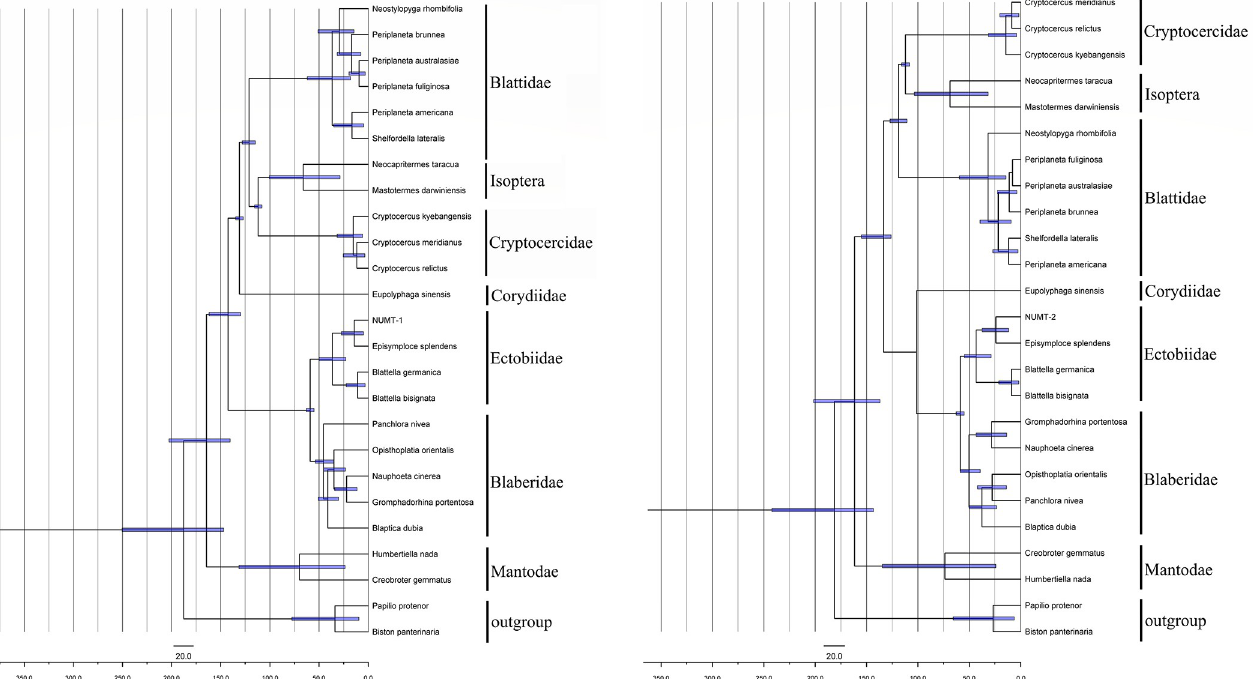
Fig 4. a. Phylogenetic chronogram of Numt-1 and blattodean species based on the sequence aligned with Numt-1, reconstructed using BEAST. The best-fit evolution model was determined by PartitionFinder. Scale bar estimates age in millions of years and blue bars represent 95% highest posterior density intervals for the node ages. Papilio protenor and Biston panterinaria were employed to root the tree as outgroups. b. Phylogenetic chronogram of Numt-2 and blattodean species based on the sequence aligned with Numt-2, reconstructed using BEAST. The best-fit evolution model was determined by PartitionFinder. Scale bar estimates age in millions of years and blue bars represent 95% highest posterior density intervals for the node ages. Papilio protenor and Biston panterinaria were employed to root the tree as outgroups.